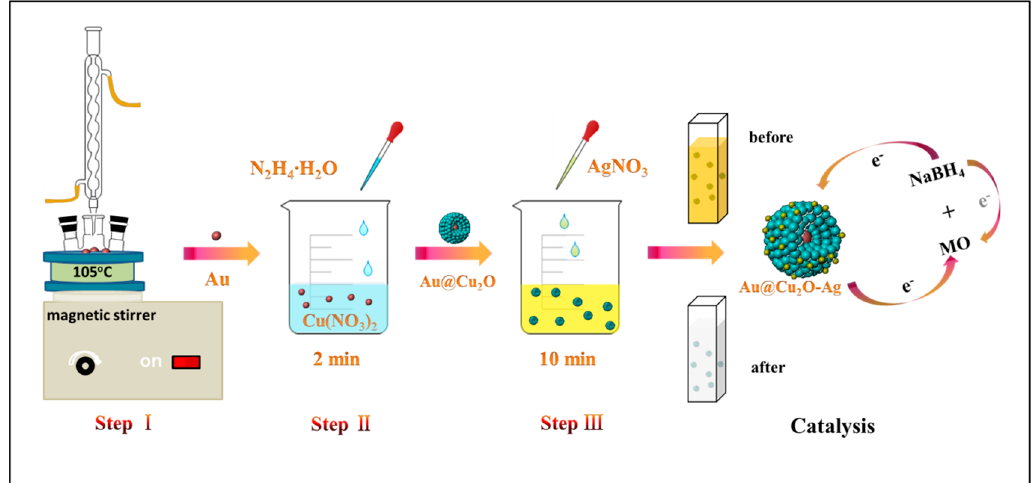
Figure 1. Scheme of the synthesis protocols of AC-1-Ag nanocomposites (NCs) and the degradation process for methyl orange (MO) by AC-1-Ag NCs with help of sodium borohydride (NaBH 4 ).